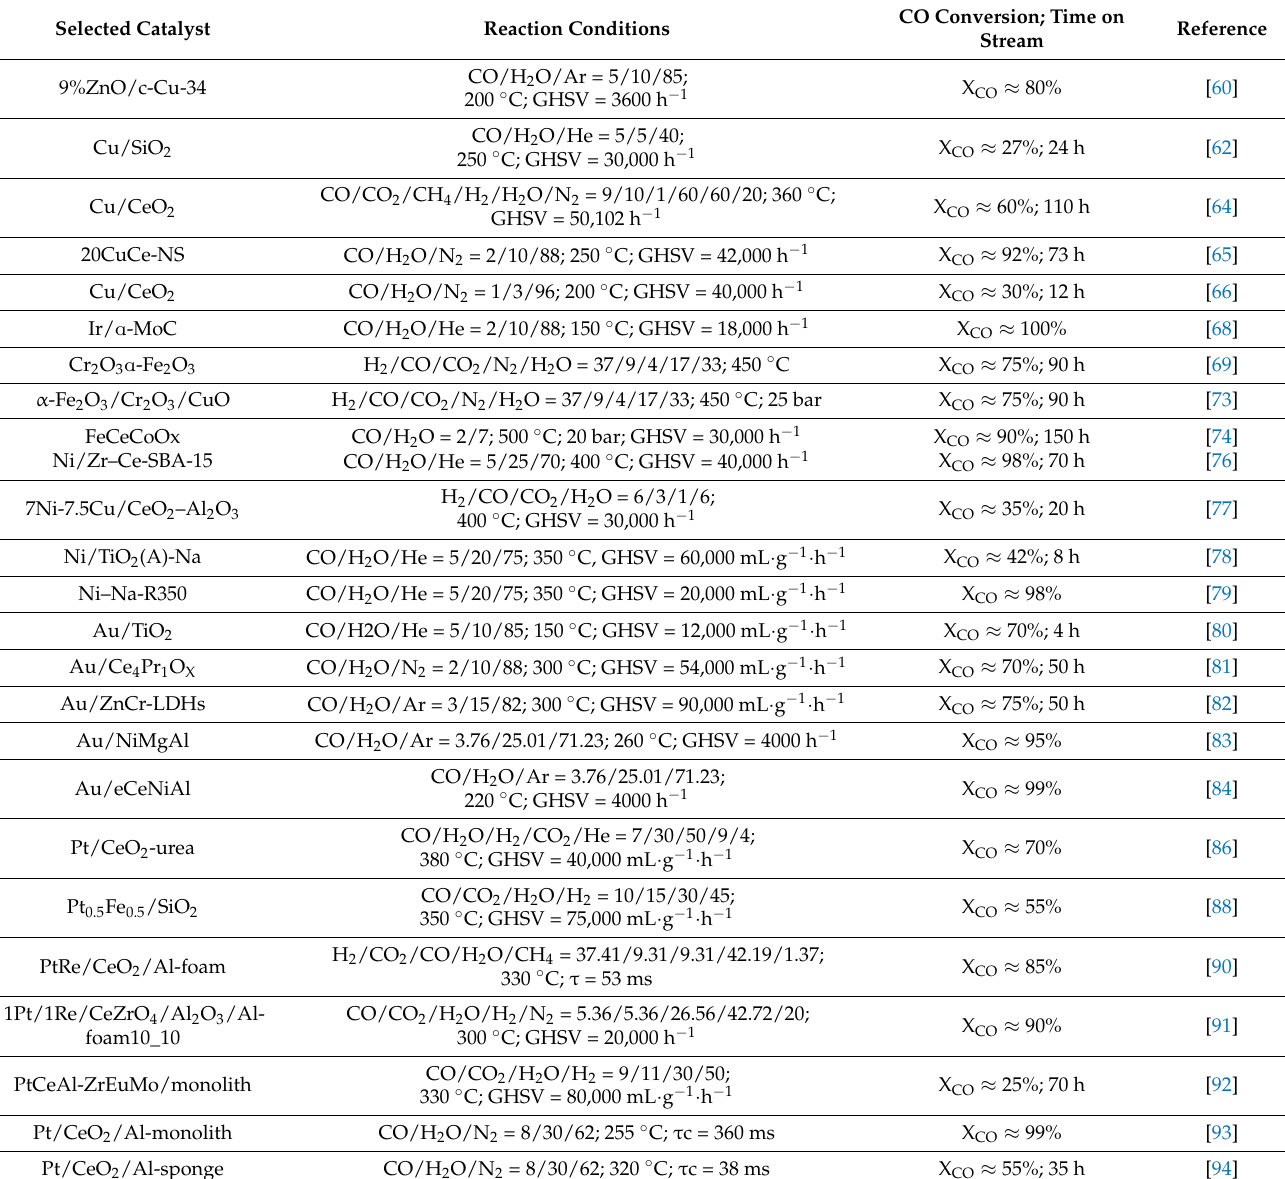
Table 3. Selected catalysts in reviewed articles in WGS section: reaction conditions and CO conversion (X CO